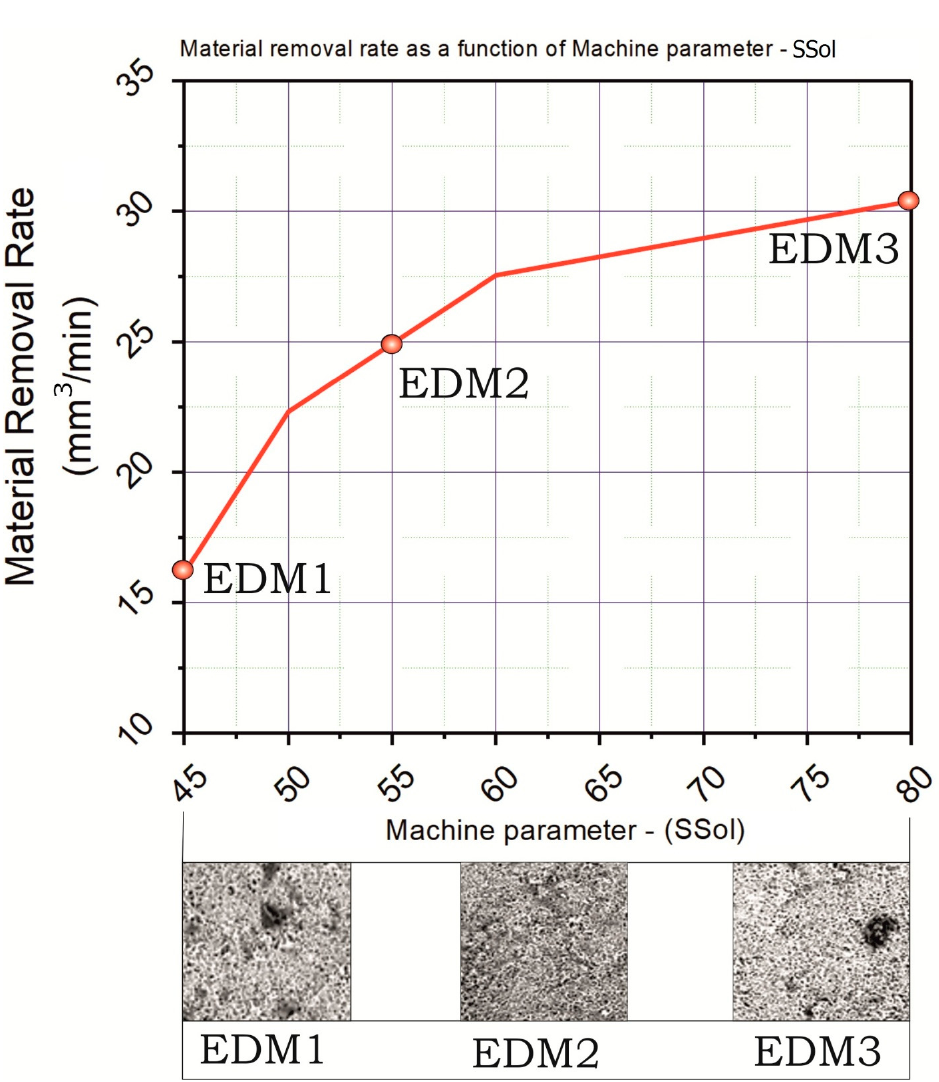
Figure 2. EDS micrographs depicting chemical composition of the ceramic workpiece measured using Phenom ProX. The impact of the machine parameter SSol on the material removal rate is shown in Figure 3. EDM regimes with SSol = 45, 55, and 80 are denoted as EDM1, EDM2, and EDM3, respectively. As seen in Figure 3, the material removal rate increases as SSol grows.